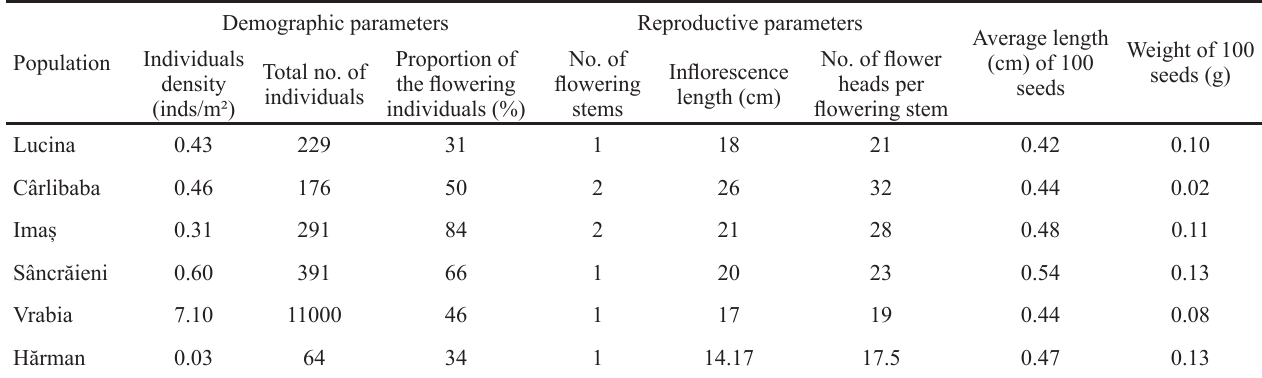
Table 2 – Performance of Ligularia sibirica populations expressed through the demographic and reproductive parameters. In the table are listed the median values of the reproductive parameters of the L. sibirica